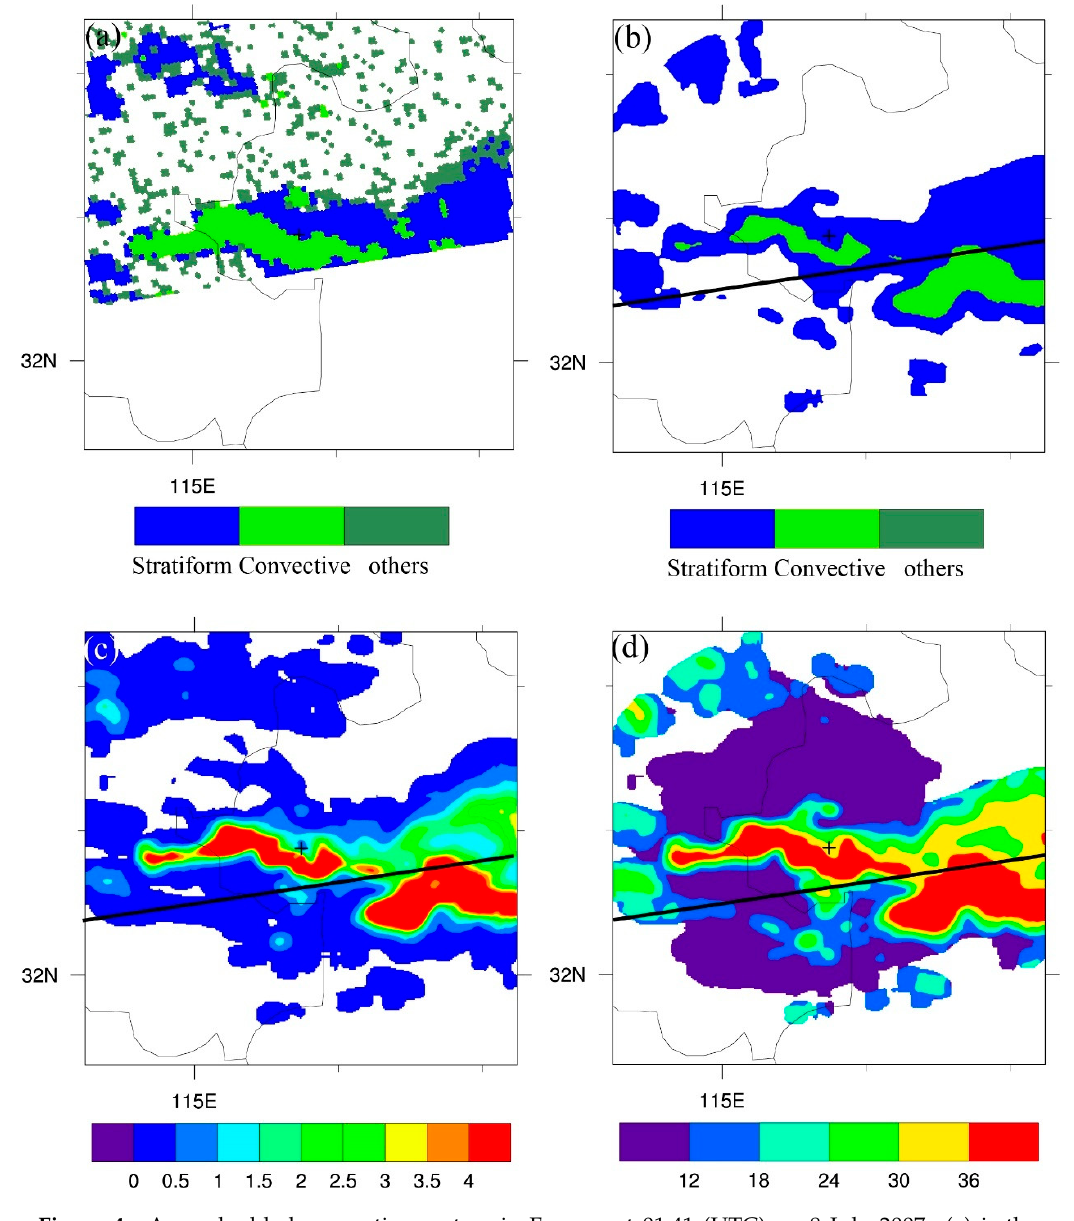
Figure 4. An embedded convective system in Fuyang at 01:41 (UTC) on 8 July 2007: ( a ) is the classification of the 2A23 product, ( b ) is the KNN classification, ( c ) is VIL, and ( d ) is ref2km. The bold black line represents the boundary of the PR scan range.